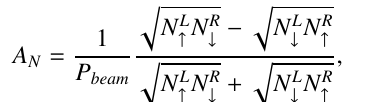
Figure 6. Comparison of the pion production [21].